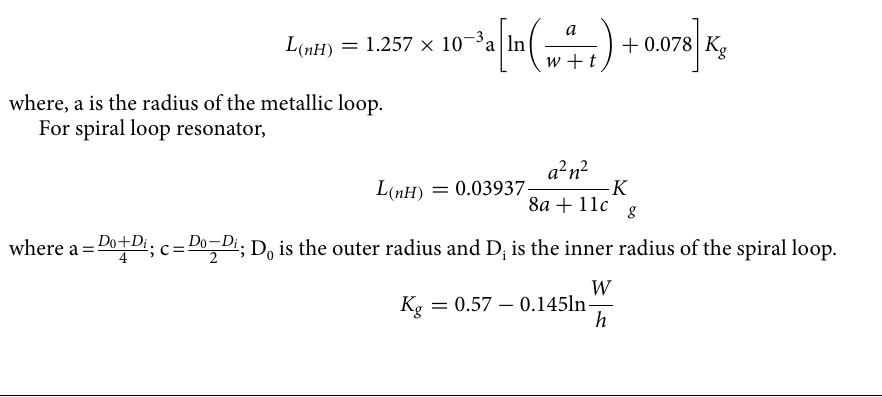
The split distance in the inner ring Space between two split rings Space between the inner spiral shape